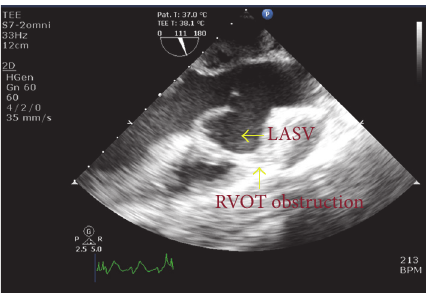
Figure 1: Transesophageal echocardiography ∗ revealed left sinus of Valsalva aneurysm with thrombus within it causing RVOT obstruction. ∗ Aortic valve long-axis view at midesophageal level.